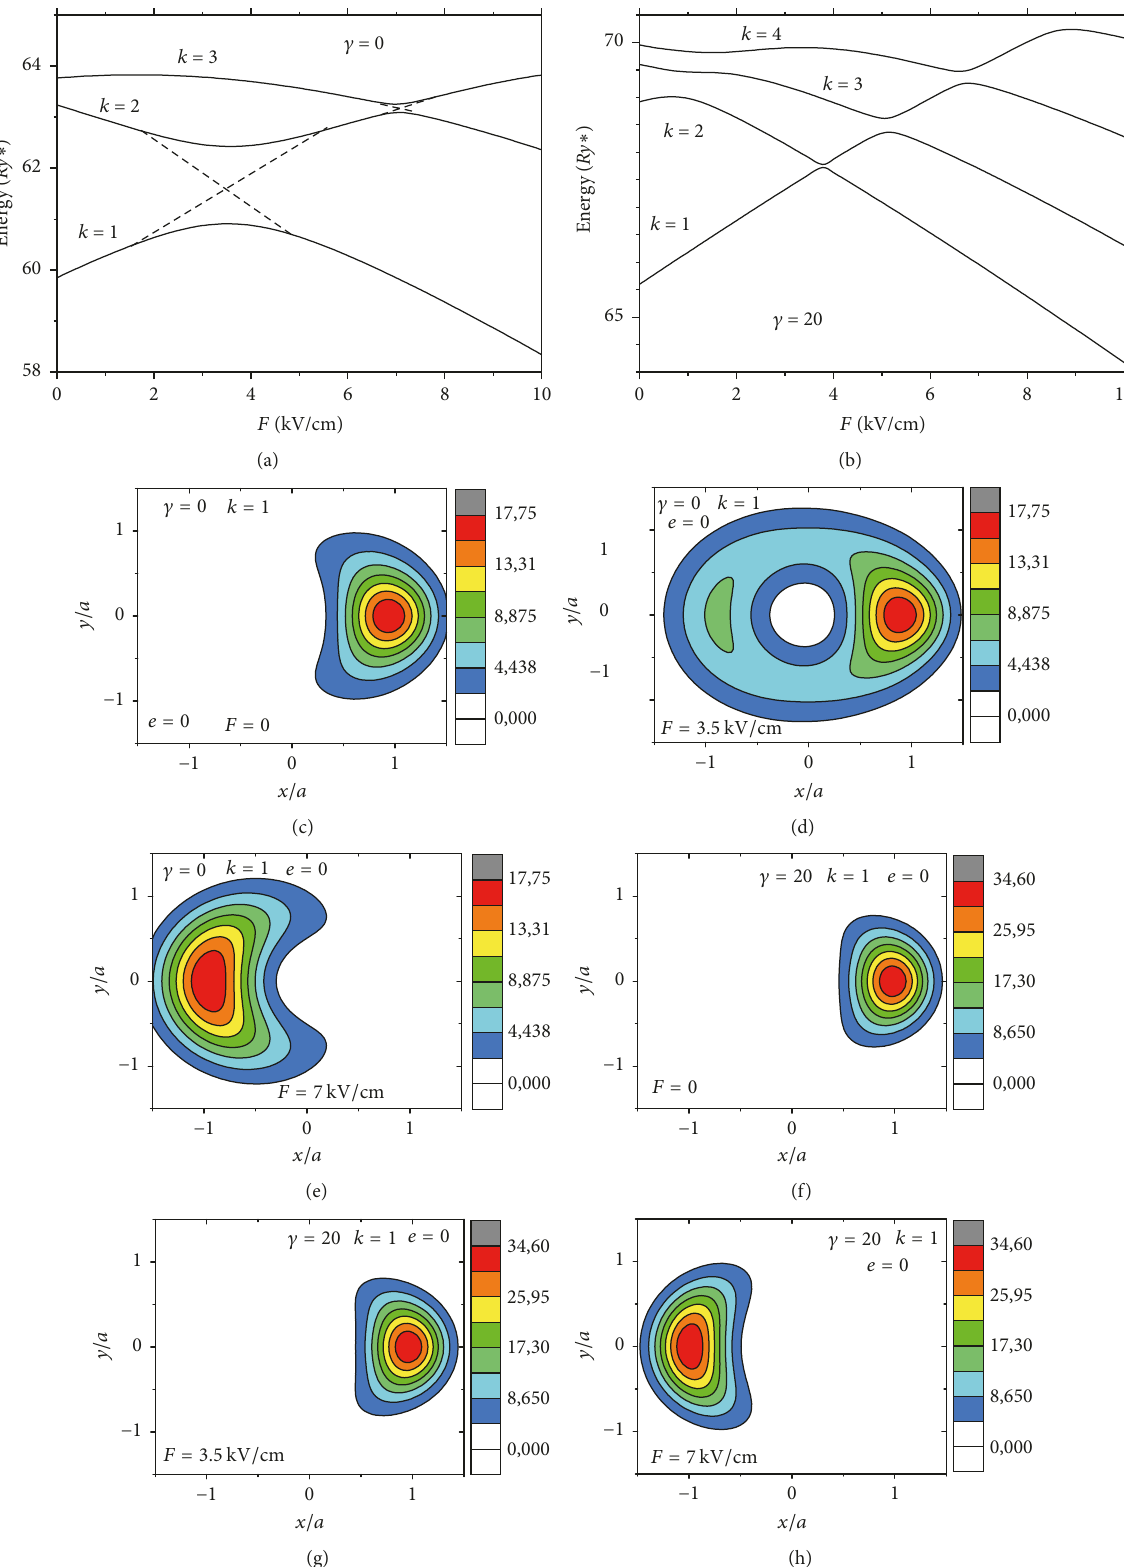
Figure 11: Lower energies of donor located at the crater’s rim of the circular QR as functions of the electric field in the cases (a) zero-magnetic field and (b) 𝛾 = 20 and contour plots for corresponding charge